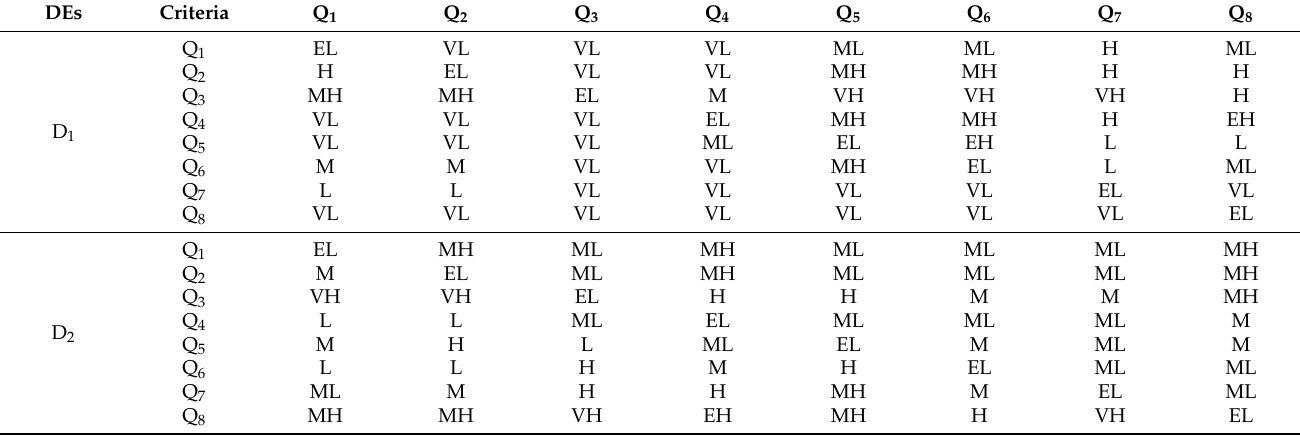
Table 5. The fuzzy direct-influence